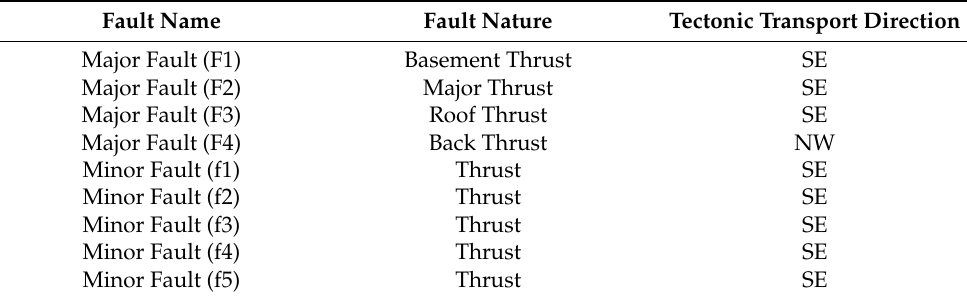
Table 4. Major and minor faults marked on seismic